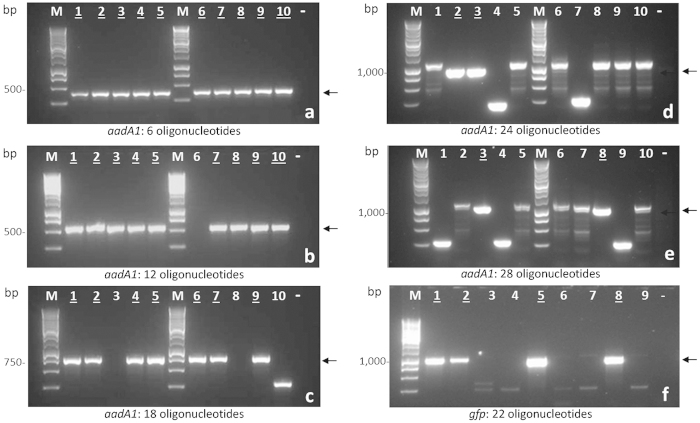
Gel electrophoresis of PCR products derived from amplification of the pRG1.0 region containing synthetic aad1 or gfp inserts. (a) aad1 six oligonucleotide assembly. (b) aad1 12 oligonucleotide assembly. (c) aad1 18 oligonucleotide assembly. (d) aad1 24 oligonucleotide assembly. (e) aad1 28 oligonucleotide assembly. (f) gfp 22 oligonucleotide assembly. M is a 1 kb ladder (Promega). Arrows indicate the expected positions of PCR products which were 401 (a), 575 (b), 749 (c), 923 (d), 1040 (e) and 965 (f) bp. Underlined numbers in each lane represent samples with the correct sized inserts that were also sequence verified. Lanes labelled – are negative controls.